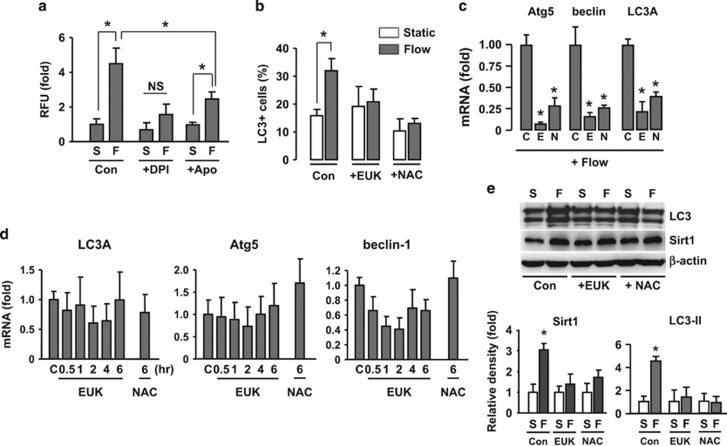
Shear stress-induced autophagy in EC was redox dependent. (a) ROS production measured with Amplex Red Hydrogen Peroxide Assay in cells maintained under laminar flow and static conditions, in the absence and presence of the NADPH oxidase inhibitors diphenyleneiodonium (DPI; 10 μM) and diapocynin (100 μM). (b) Effects of EUK-134 (10 μM) and N-acetyl cysteine (NAC; 1 mM) on flow-induced LC3 puncta accumulation. (c) Effects of EUK-134 (E) and NAC (N) on the expression levels of Atg5, beclin-1, and LC3A in cells maintained under flow condition. (d) Effects of EUK-134 on the expression levels of Atg5, beclin-1, and LC3A in cells maintained under static condition. (e) Western blot and densitometry data showing the effects of laminar flow on protein levels of Sirt1 and LC3 in the absence and presence of EUK-134 or NAC. Data are mean±S.E.M. *P<0.05, unpaired t-test or one-way analysis of variance as appropriate (n=3–5). S, static; F, flow; NS, no significance; Apo, diapocynin; NAC, N-acetyl cysteine